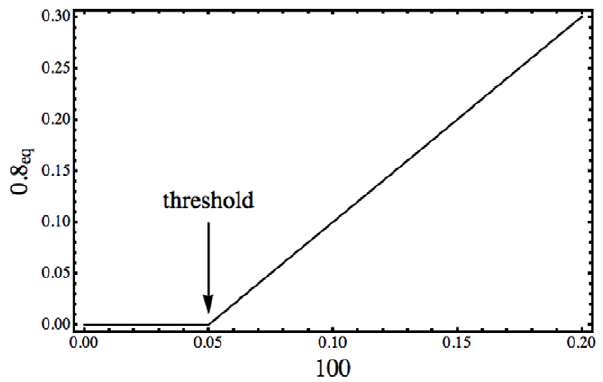
Figure 5. Dependence of the protein steady state on the total concentration of the gene. Below the bifurcation or threshold c ~ a { a d A = a a p A , the equilibrium value of protein concentration A eq is zero, while above it takes the value A eq ~ ( p A ca a { d A a { a ) = ( d A a a ) . The parameters are: a a ~ 1 : 0 , a { a ~ 0 : 1 , p A ~ 0 : 2 and d A ~ 0 : 1 .